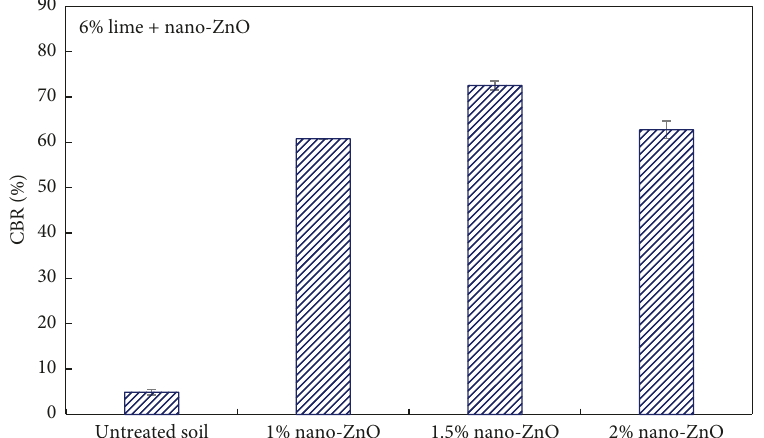
Figure 9: Effect of nano-ZnO on the CBR of lime-stabilized soil after 7days of treatment.